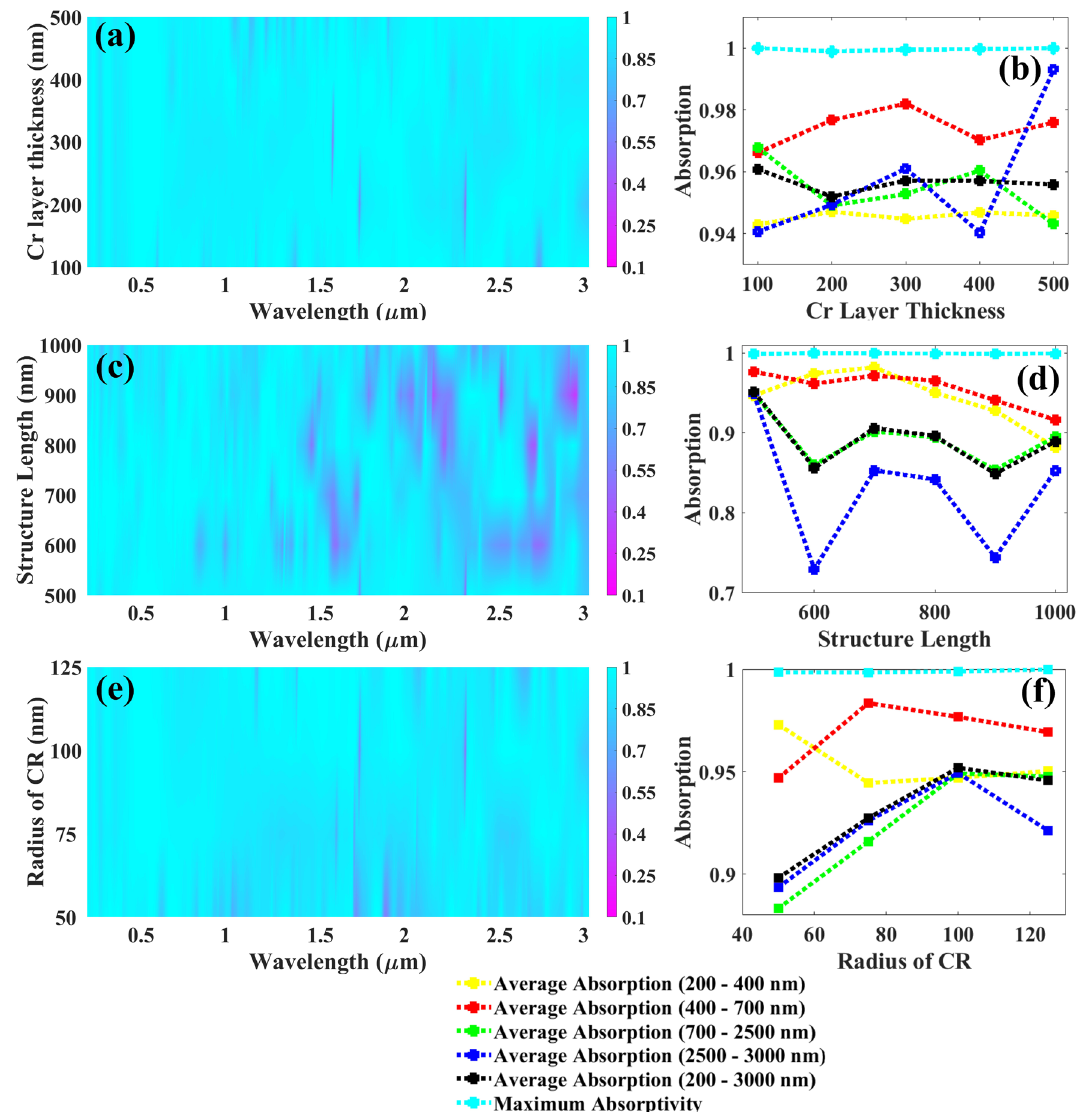
Figure 4. Various UWBSEA physical parameters affecting the absorption response, ( a ) thickness of chromium layer affecting the absorption response, ( b ) line plot indicating the change in average absorption for various regions including UV to MIR as well as maximum absorptivity as we increase the chromium layer thickness from 100 to 500 nm with the gradual change of 100 nm, ( c ) length of a structure affecting the absorption response, ( d ) line plot indicating the change in average absorption for various regions including UV to MIR as well as maximum absorptivity as we increase the structure length from 500 to 1000 nm with the gradual change of 100 nm, ( e ) radius of circular resonator affecting the absorption response, ( f ) line plot indicating the change in average absorption for various regions including UV to MIR as well as maximum absorptivity as we increase the circular resonator radius from 50 to 125 nm with the gradual change of 50